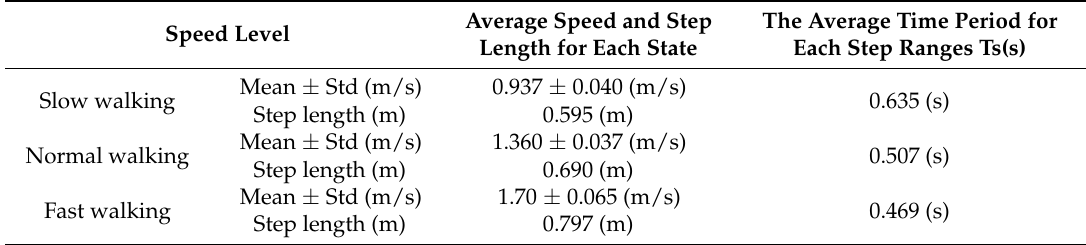
Average Speed and Step Length for Each State